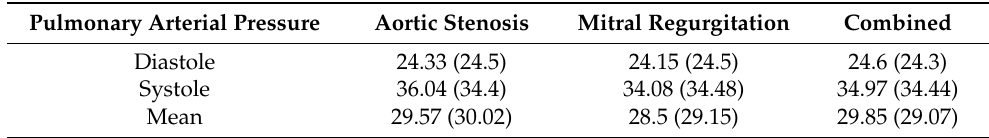
Table 10. Global results for diseased heart valve cases with induced PAH (values in parentheses are the true pseudo-measurement